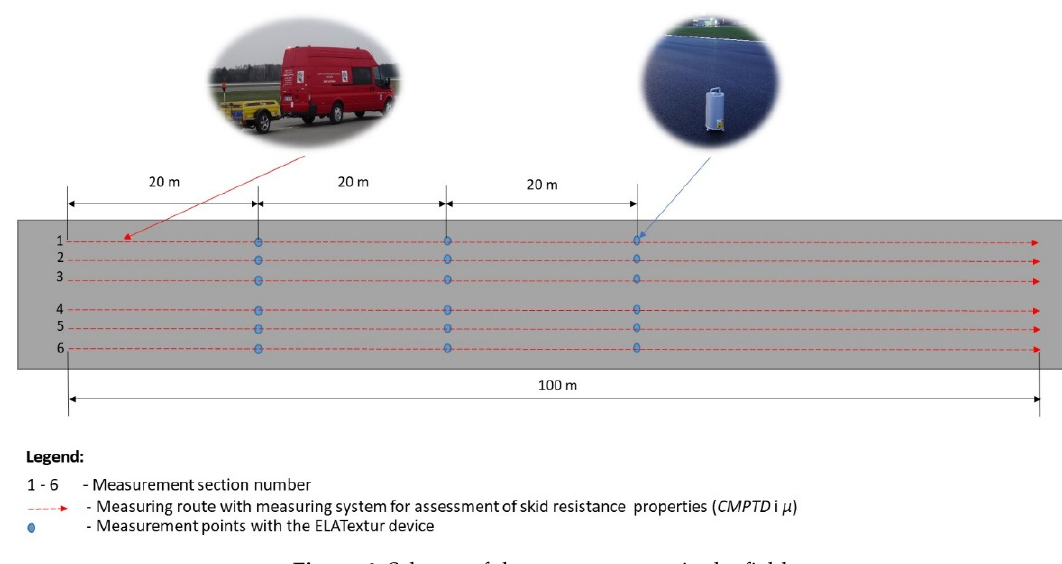
Figure 6. Scheme of the measurements in the field.